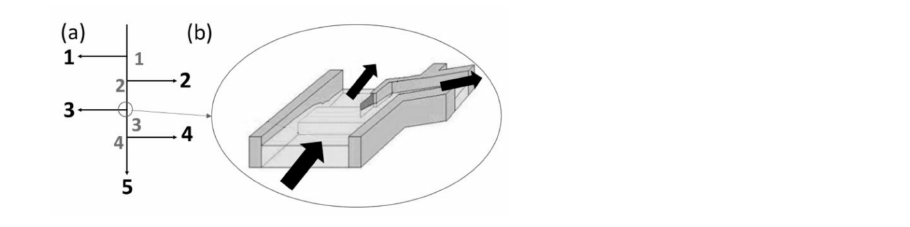
Figure 2. Proportional flow dividers. ( a ) Flow divider location in a canal; the blue numbers represent the nodes and the black numbers the users. ( b ) Flow divider diagram.